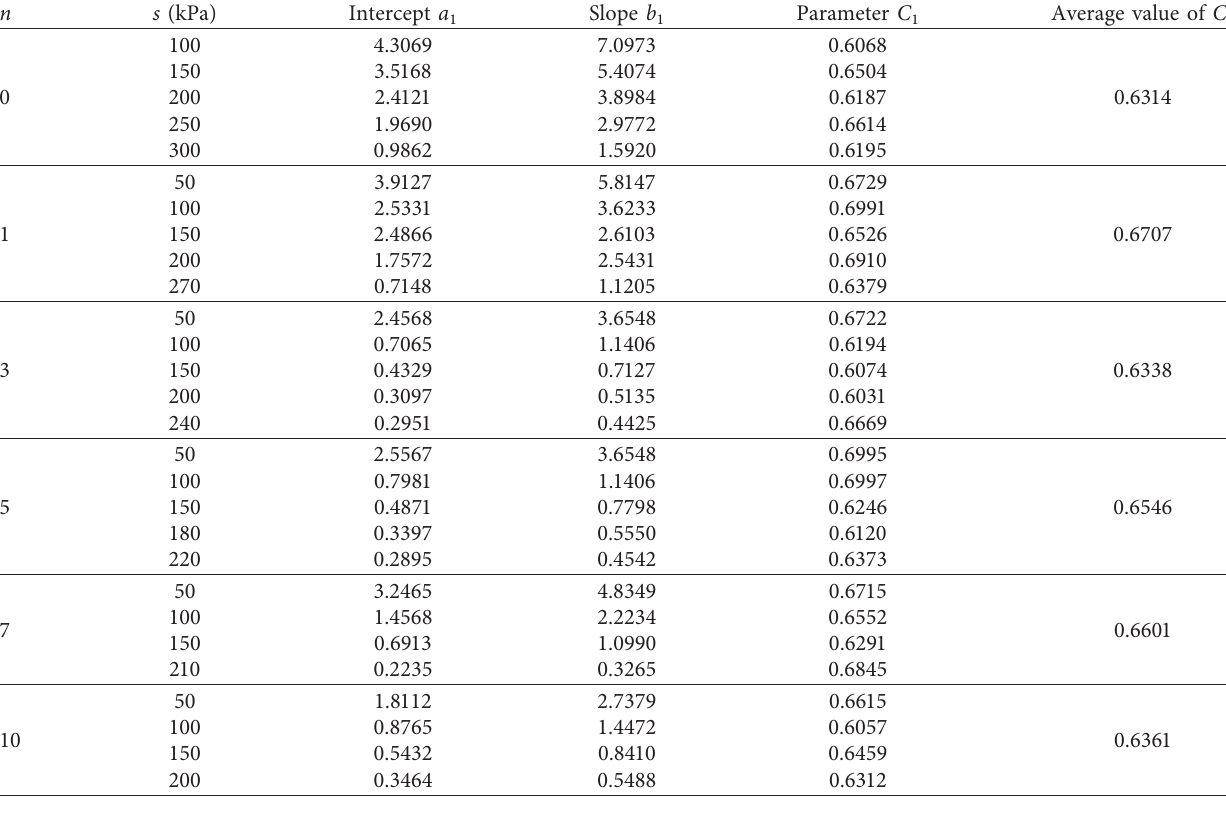
Table 6: Parameter values under different numbers of dry-wet cycle when q is equal to